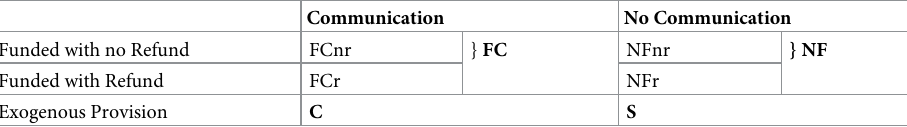
Table 1. Overview of